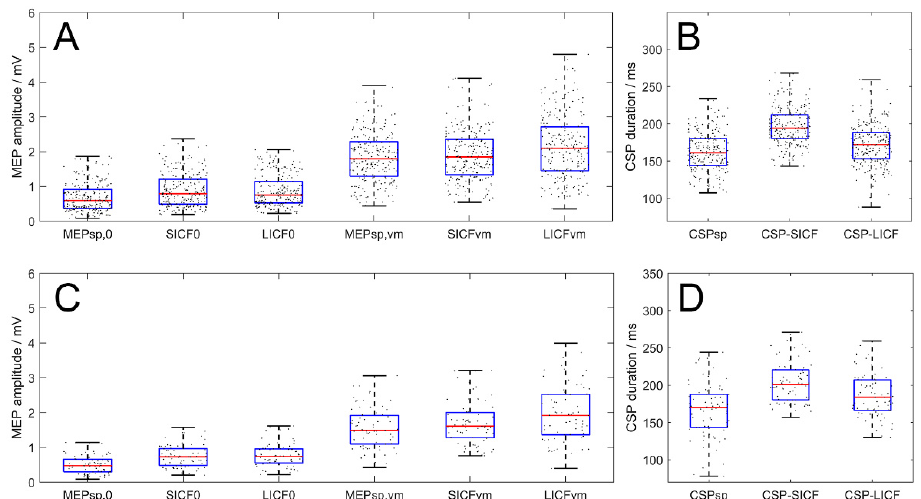
Figure 4. Paradigm ‐ wise effects of MEP amplitude and CSP duration of all timepoints (real ‐ and sham ‐ rTMS group, upper and lower panel respectively). ( A , C ) Amplitude of MEP sp , MEP SICF and MEP LICF . In VM condition, MEP LICF demonstrated significant facilitatory effect while the facilitation of MEP SICF was absent. ( B , D ) CSP duration in the three paradigms. CSP SICF and CSP LICF duration were longer than the CSP sp , with CSP SICF significantly longer than CSP LICF . Boxes denote 25th and 75th percentile values, whiskers denote minimum and maximum values.